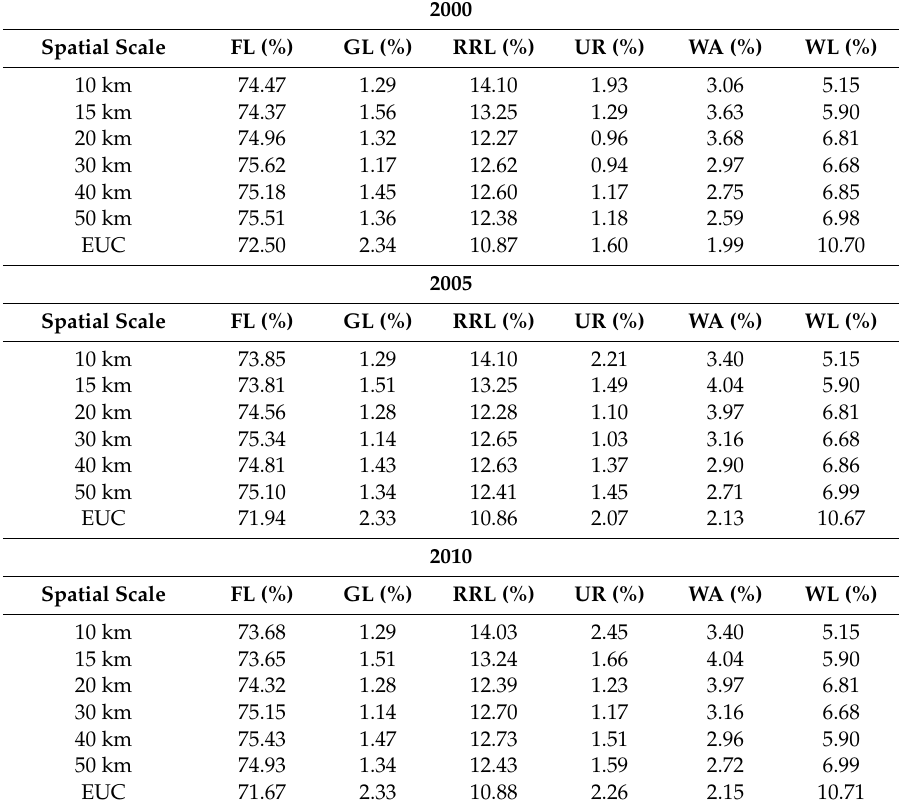
Table 3. The proportion of the six land use types in 2000, 2005 and 2010 in seven spatial